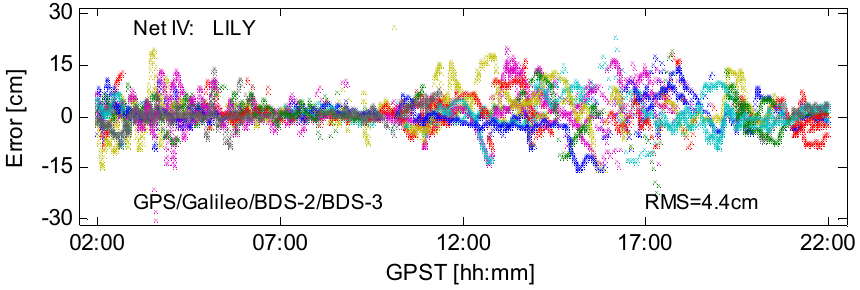
Figure 10. BSSD ionosphere interpolation errors of GPS/Galileo/BDS-2/BDS-3 at station LILY.